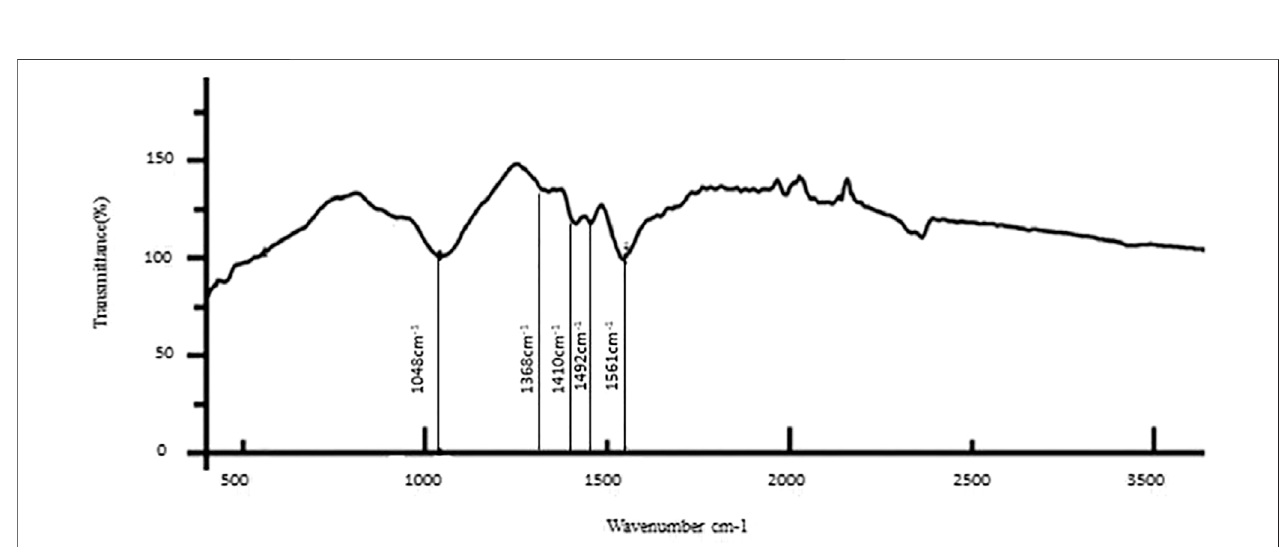
FIGURE 4 | Bioactive evaluation of glass ionomer cement (GIC) and silver nanoparticles (AgNPs) 0.2% sample with dentin.